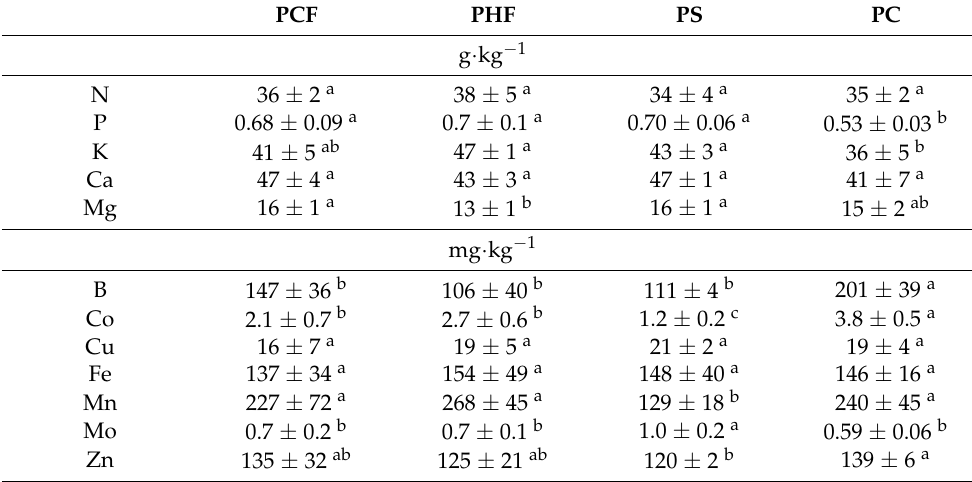
Table 7. Nutrient concentration of pepper plants cv. Brocanto grown in commercial greenhouses in the C soil (PC) and S soil (PS) treated with MCT ® products and with different solutions PCF (conventional treatment) and PHF (plants with MCT ® treatment). Data are presented as the mean ± standard deviation. Different letters indicate significant differences between treatments ( n = 4; Duncan’s test, p <